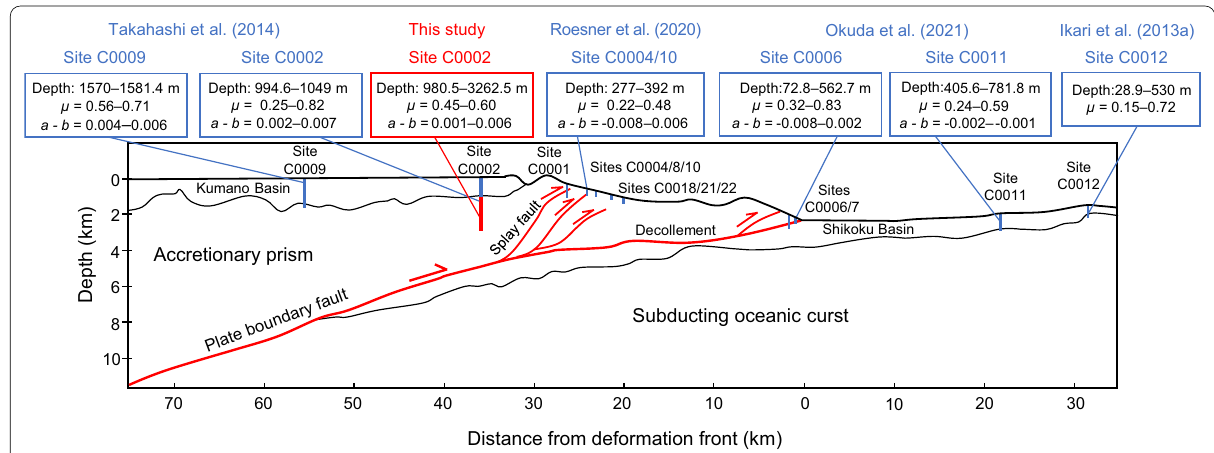
Fig. 11 Cross section of the Kumano transect across the Nankai accretionary prism (modified after Tobin et al. 2020), constructed using data from various drilling sites during the NanTroSEIZE expeditions, with the frictional properties at Sites C0002 (this study, Takahashi et al. 2014), C0009 (Takahashi et al. 2014), C0004/10 (Roesner et al. 2020), C0006 and C0011 (Okuda et al. 2021), and C0012 (Ikari et al.